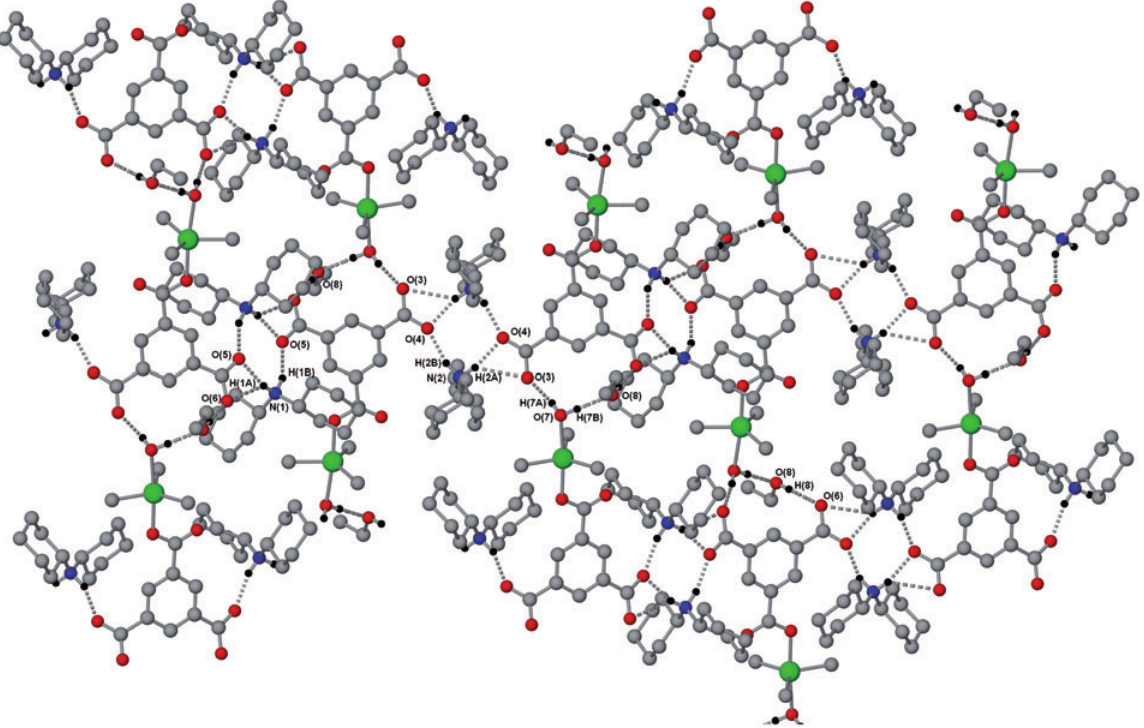
Figure 2 The lattice structure of 1 showing intermolecular hydrogen bonds (dotted lines). Hydrogen bond data.